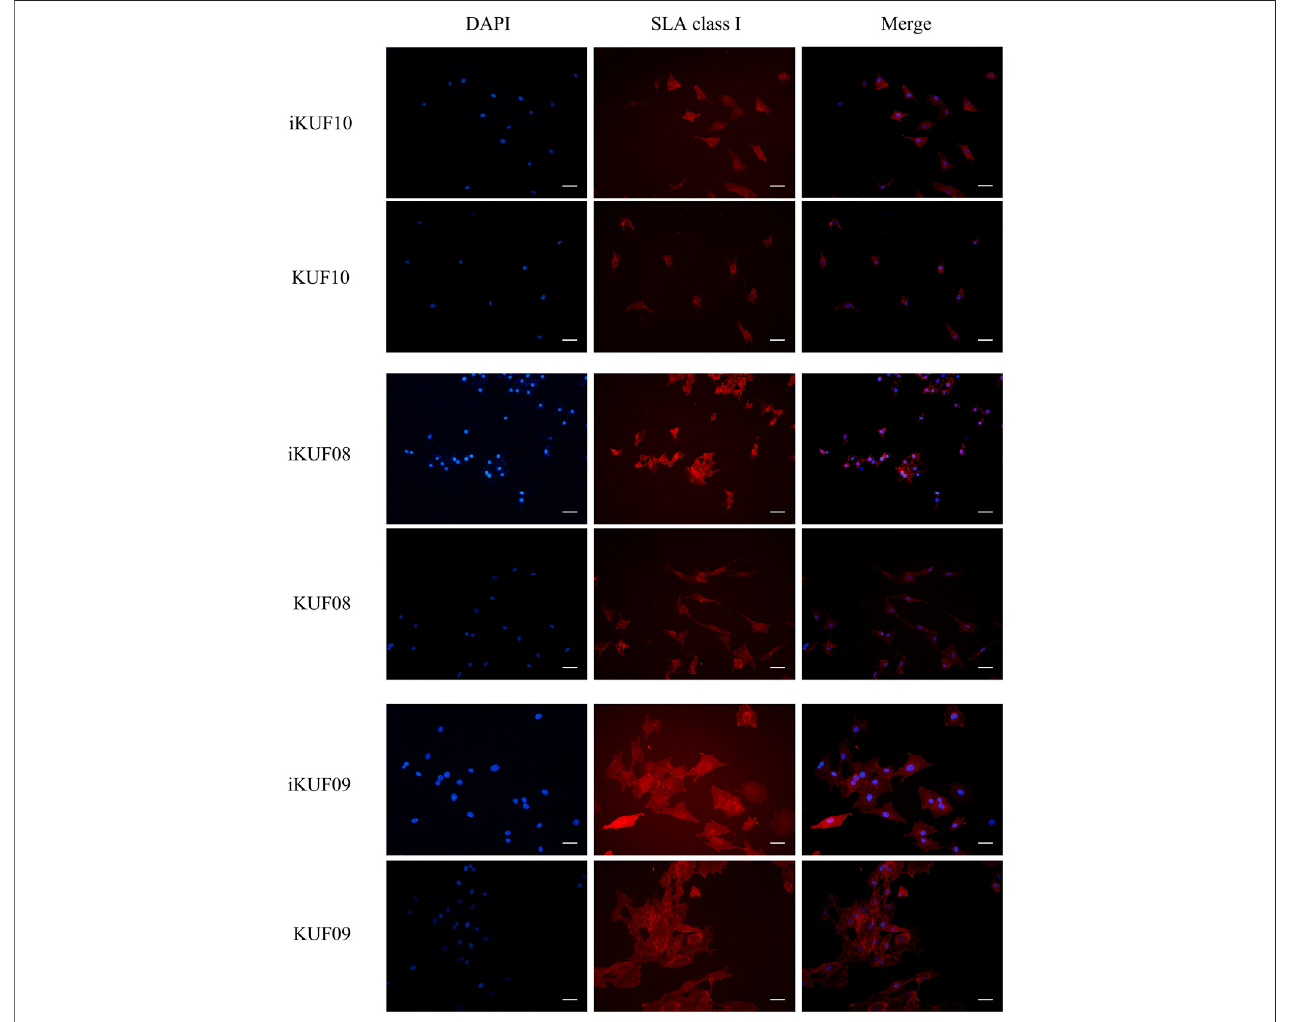
FIGURE 6 | Immunohistochemical comparison of SLA classical class I gene expression between primary and immortalized cells. Three immortalized cell lines, iKUF10, iKUF08, and iKUF09 and corresponding primary cells, KUF10, KUF08 and KUF09 were used. The fi rst and second columns show the results of DAPI staining and immunostaining by anti-pan SLA classical class I antibodies, respectively. The merged images of the two are shown in the third column. The fi rst and second rows correspond to immortalized and primary cells, respectively. Scale bar: 50 µm. Magni fi cation: × 20. The representative image from the triplicate analysis is shown.